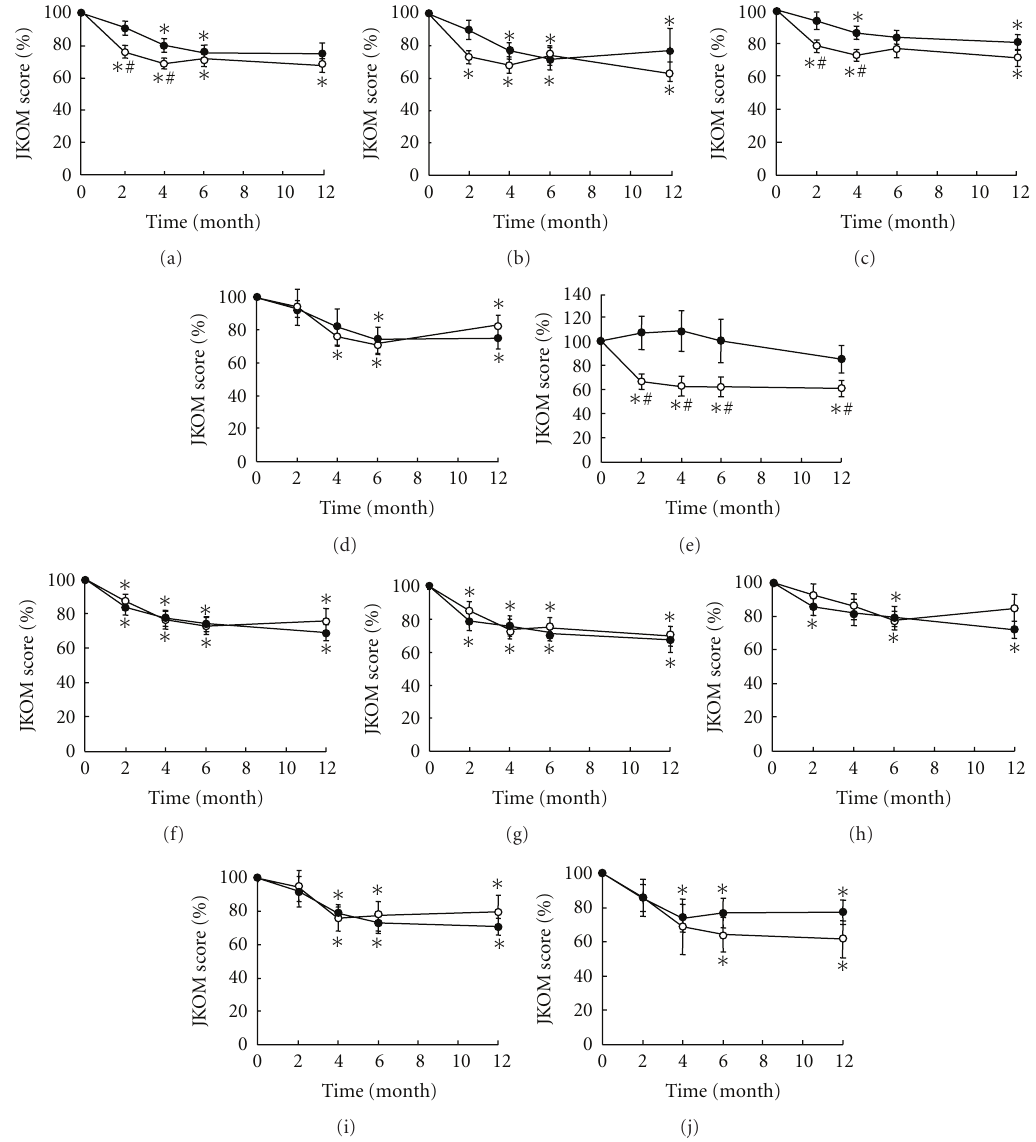
Figure 1: Change in JKOM score with respect to subject’s age. Subjects were divided into two groups of younger ( (cid:2) 70 years of age; 21 subjects) and older subjects (older than 70 years of age; 17 subjects), and change of JKOM score was evaluated in the respective groups. For younger subjects, change rate of total score relative to that at baseline (a) is shown together with rates for “pain and sti ff ness in the knees” (b), “condition of daily life” (c), “general activities” (d), and “health conditions” subscales (e). Change rates of total JKOM score and those of 4 subscales for older subjects are shown in the same manner (f–j, resp.). Open and closed circles indicate change rates of subjects given HA and placebo, respectively. Results are mean ± SE of 7 to 11 subjects. ∗ P < 0 . 05 against baseline and # P < 0 . 05 against placebo